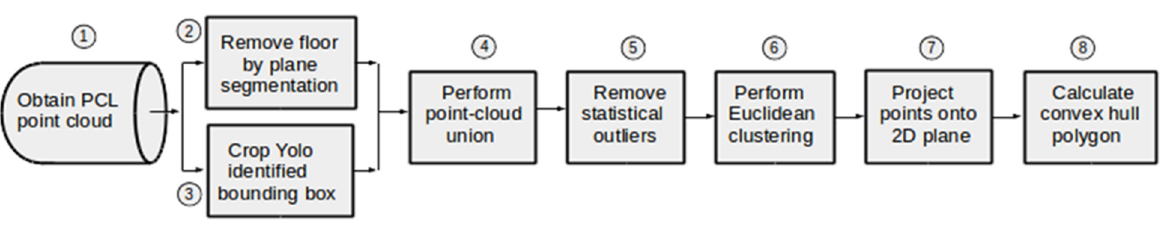
Figure 4. Point cloud processing pipeline for isolating and determining the location of a general object.